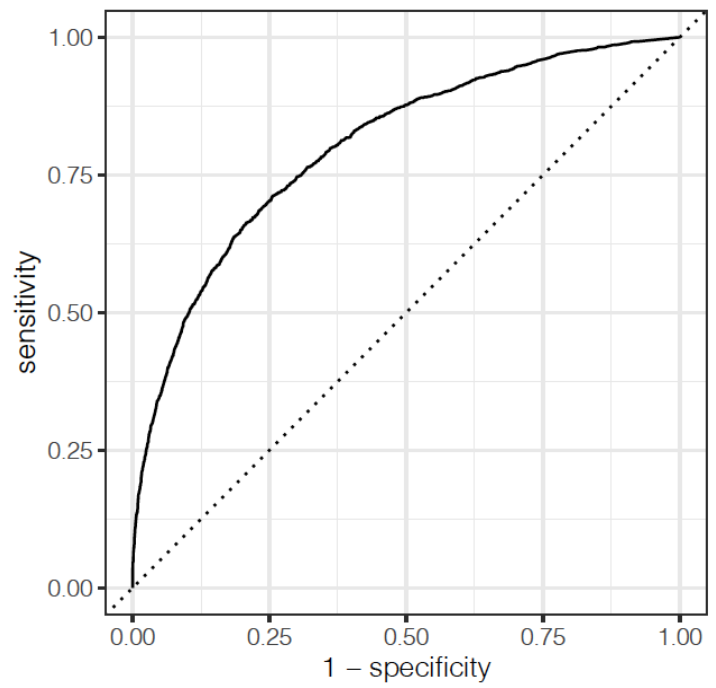
Figure 4. DNN ROC curve [AUC 0.801].